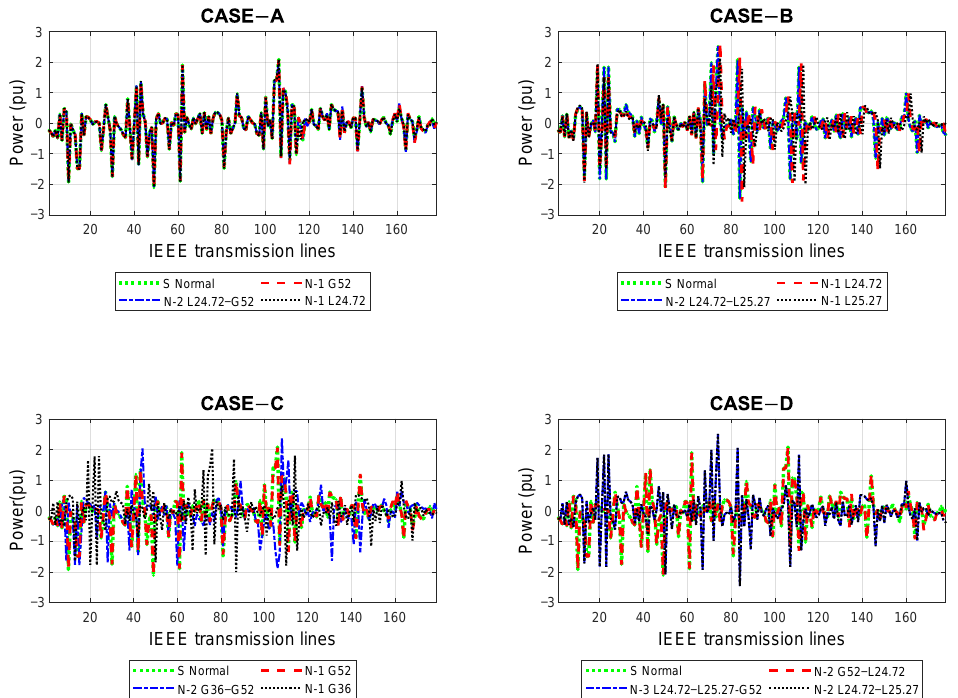
Figure 6. Power flow in transmission lines for the different study cases.